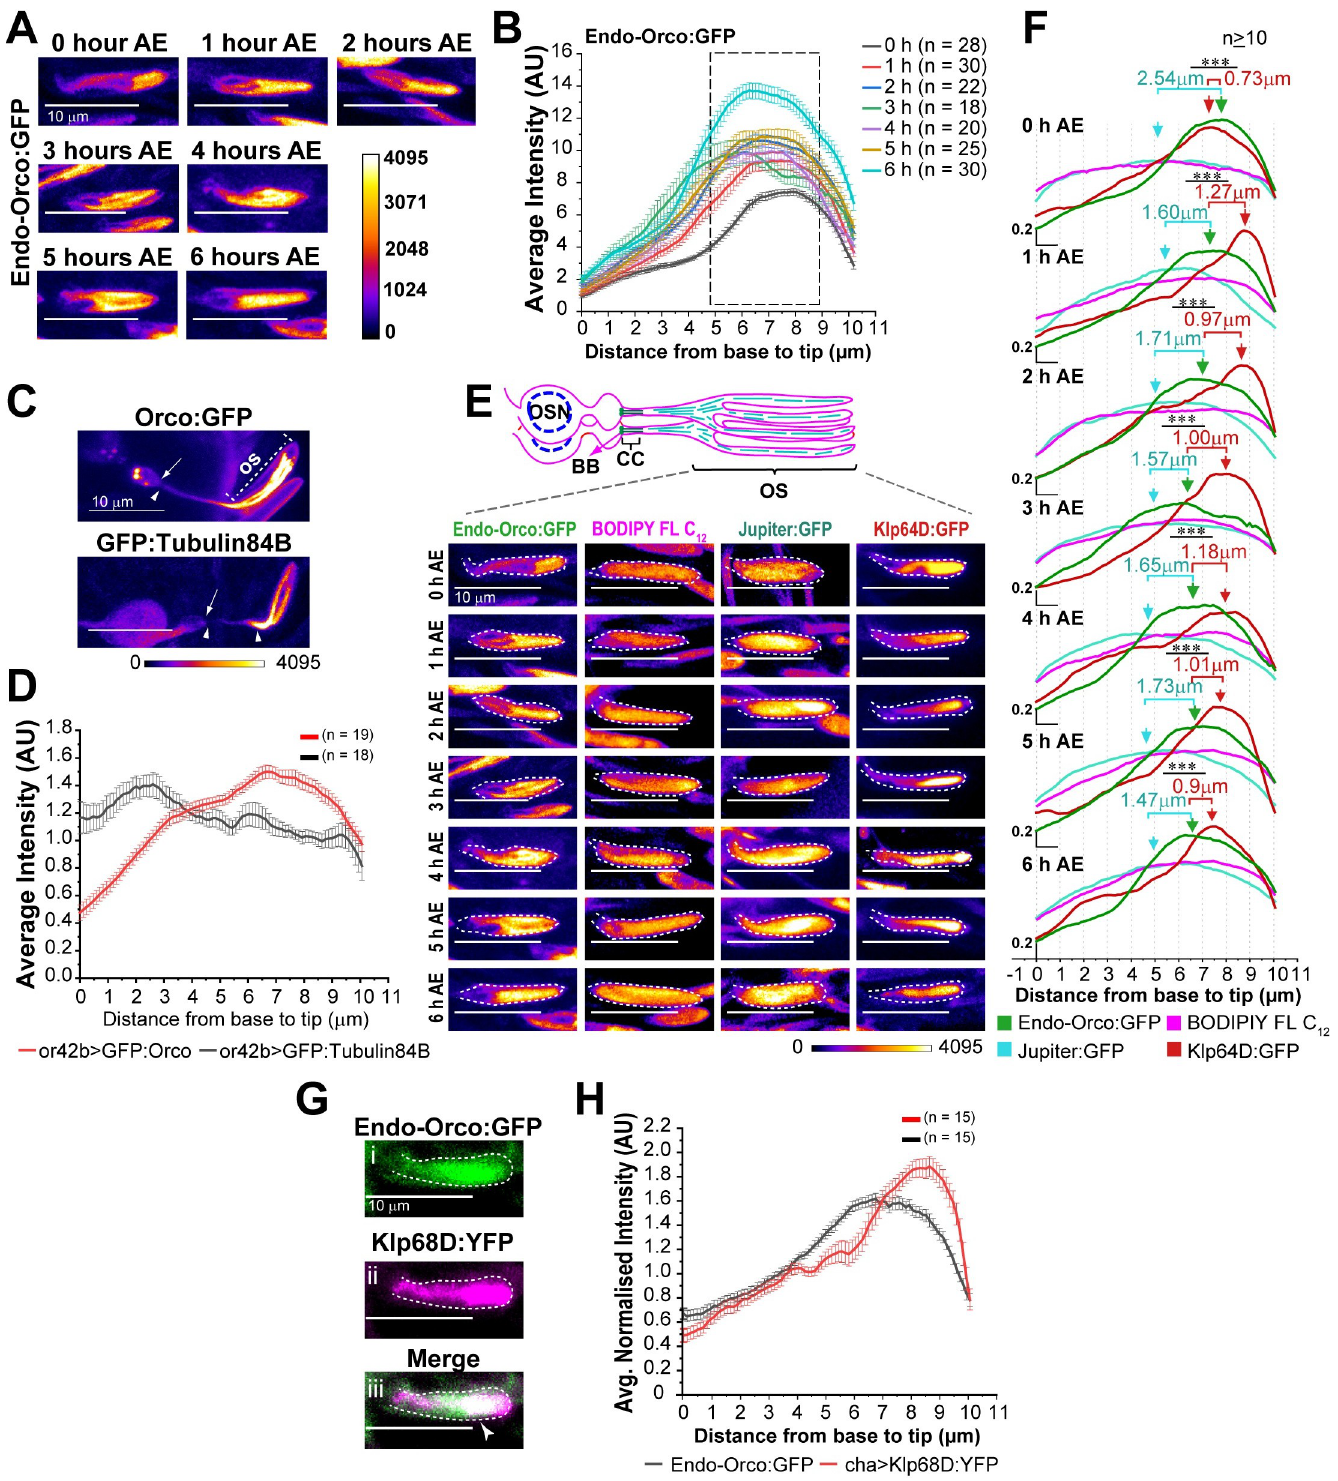
Fig 7. Orco enrichment domain in the cilia. (A-B) Fluorescence micrographs (A) and plot profiles (B) of Endo-Orco:GFP distribution (mean ± S.E.M.) along the ciliary OS inside ab1-type s . basiconica during 0–6 hours AE. (C, D) GFP:Orco and GFP:Tubulin84B localisation in single cilium expressed on OR42b neuron inside ab1-type sensilla (C) and plot profile of corresponding intensities along the cilia (D). (E, F) Fluorescence micrographs (E) and relative distribution profiles (F) of Endo- Orco:GFP, KLP64D:GFP, Jupiter:GFP and BODIPY FL C 12 along the ciliary OS inside ab1-type s . basiconica during 0–6 hours AE. The broken line marks